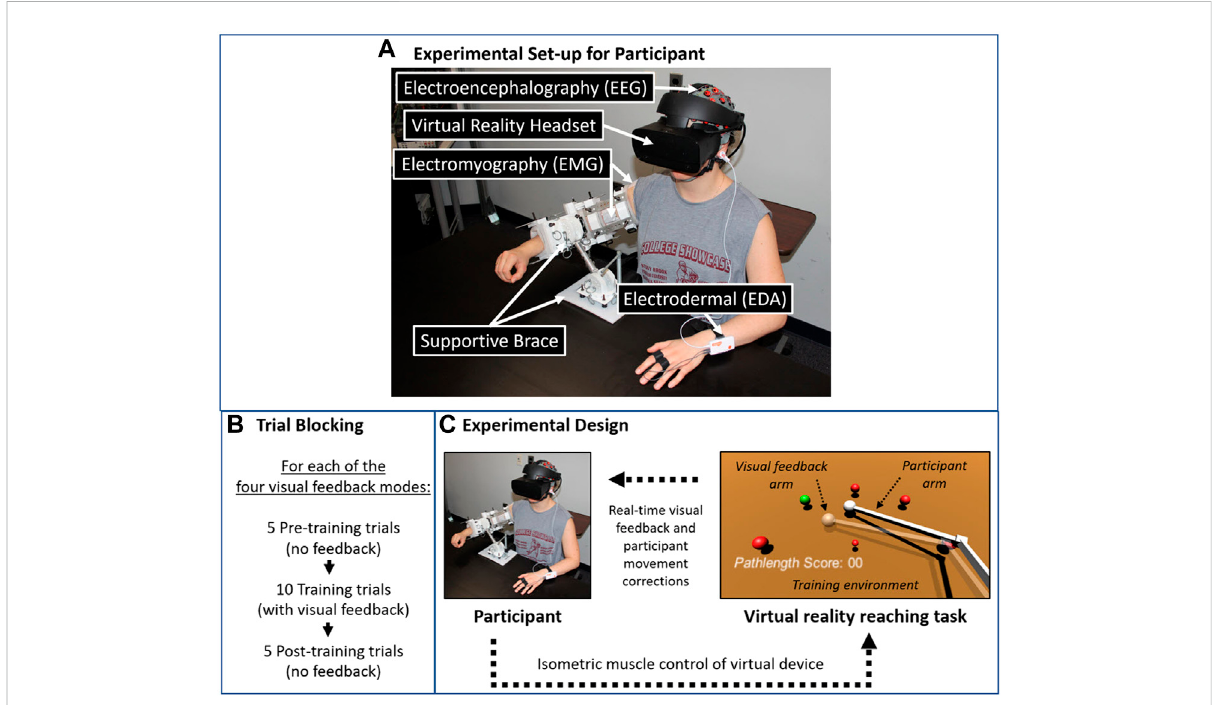
FIGURE 1 Experiment Overview. (A) Participant arm placed in supportive brace fastened to the table to apply isometric muscular exertions. Worn EMG sensors record myoelectric patterns to command the VR robot arm avatar. EEG and EDA signals additionally recorded to measure participant cognitive loading and physical arousal, respectively. (B) For each visual feedback mode, participants completed pre-training and post-training trials (with no feedback) before and after training trials (with visual feedback). (C) Isometric muscle control was used to command a virtual device through a variety of reaching tasks while receiving real-time visual feedback for making movement corrections to reduce error to the shortest path between